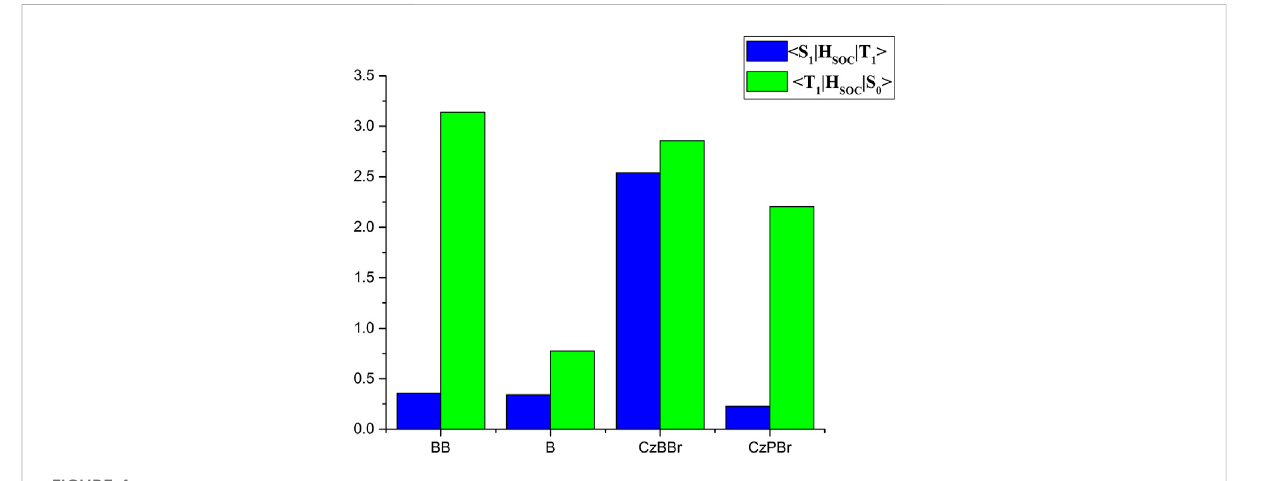
FIGURE 4 Schematic diagram of spin-orbit coupling constants.